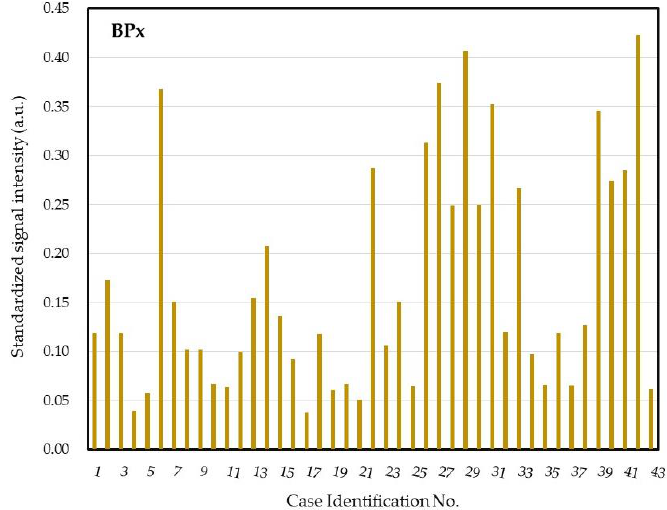
Figure 4. Molecular bioburden of the core ocular surface microbiota of the patients for cataract surgery. a.u. = arbitrary unit.